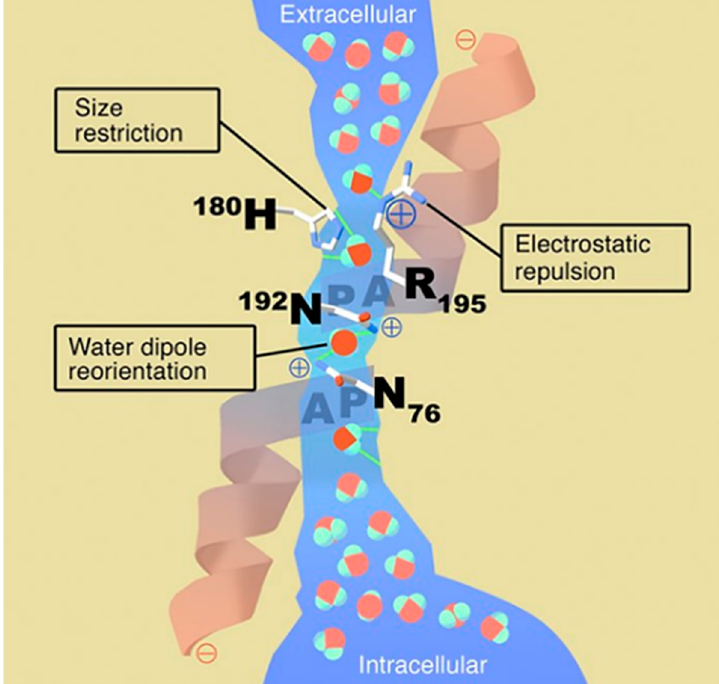
Figure 10. Aquaporin membrane structure with inter and extracellular vestibules containing bulk water and single file water molecule passage through a 20 Å span [184]. (Reproduced with the permission of Kozono et. al, J. Clin. Invest. 2002, Copyright© 2002 American Society for Clinical Investigation).